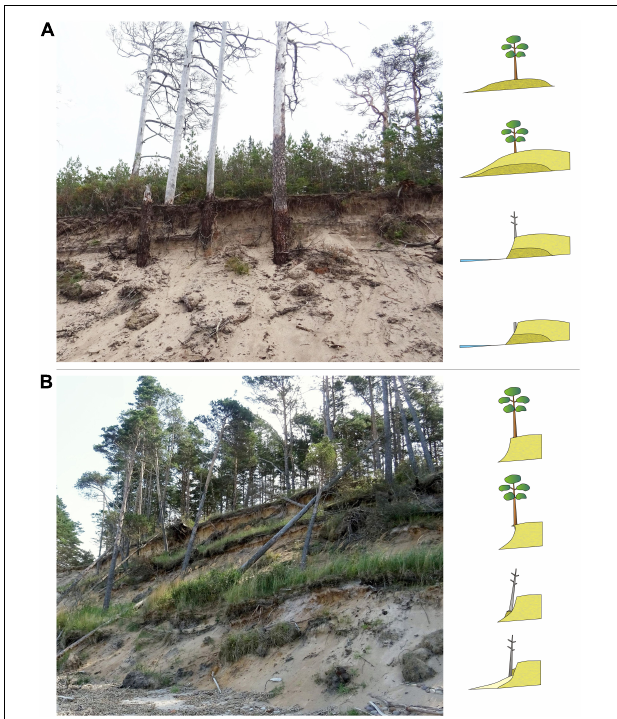
FIGURE 8 | (A) Re-exposure of pine trunks on the face of the coastal bluff long after burial (photograph from Liepene, stretch 5, tree group 3; scheme). (B) The face of the coastal bluff with pines remaining in vertical condition, having partially slumped down the face along with the soil (photograph from Staldzene, stretch 4, not sampled;